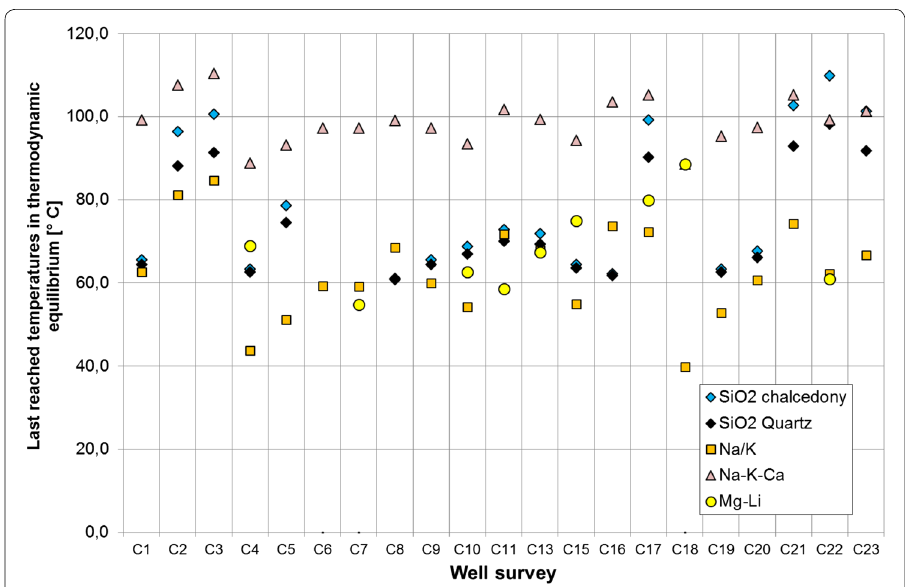
Fig. 11 Last reached temperatures in thermodynamic equilibrium. Estimated with chalcedony, quartz, Na–K, Na–K–Ca, and Mg–Li